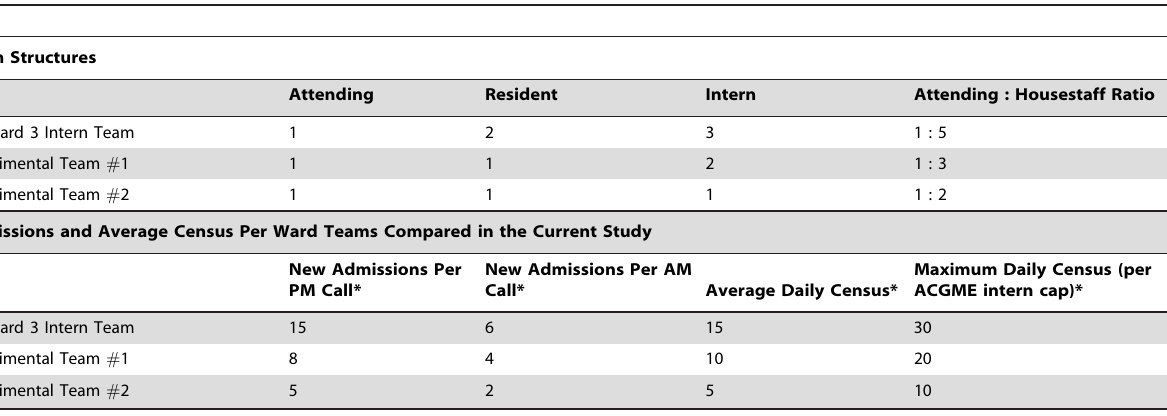
Table 1. Structure, Admissions, and Average Census of 3 Versions of Ward Teams Compared in the Current Study.